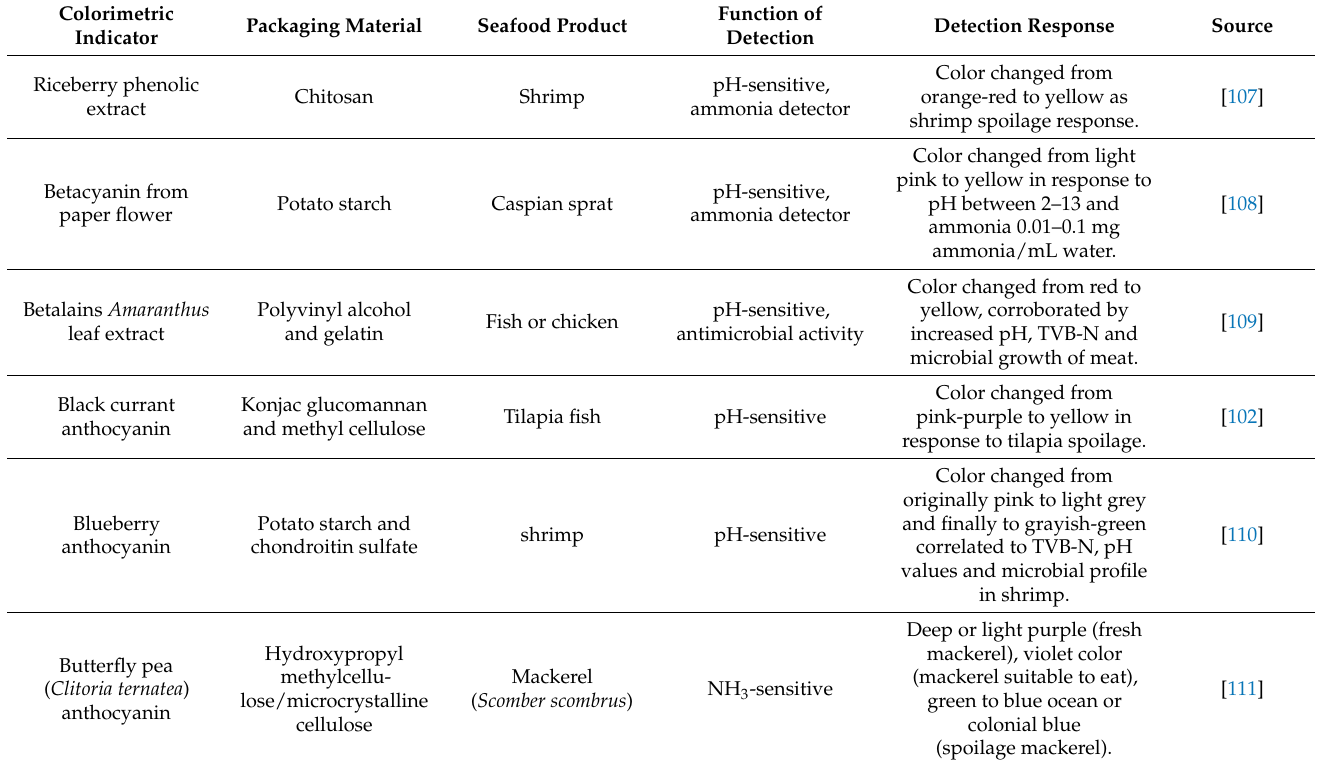
Table 2. Related research on intelligent packaging for seafood